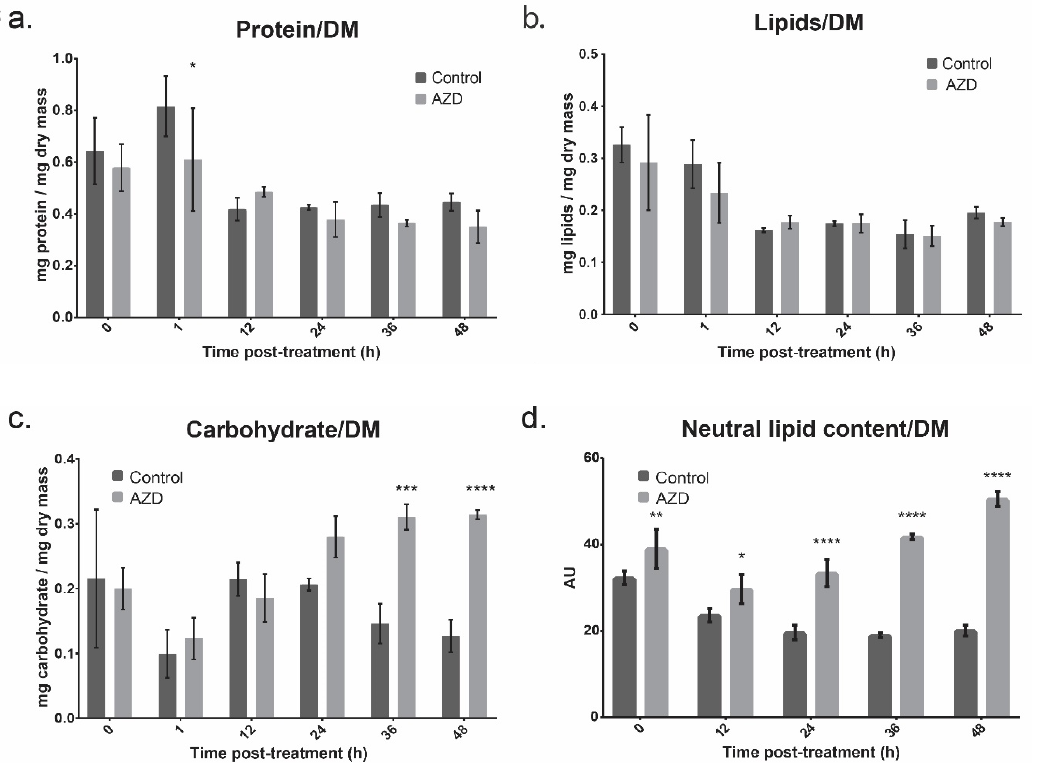
Figure 3. Compositional analysis of C. reinhardtii cultures with and without AZD8055 treatment, taken over time. The error bars represent standard deviation and statistical differences indicate a difference between the inhibited and non-inhibited cultures at one time point. Significance is denoted by asterisks, where * indicates p ≤ 0.05, ** indicates p ≤ 0.01, *** indicates p ≤ 0.001, and **** indicates p ≤ 0.0001. ( a ) The total protein content of the cultures, measured in mg/mg dry mass, with and without AZD8055 treatment. ( b ) The total lipid content of cultures, measured in mg/mg dry mass. ( c ) The total carbohydrate content of cultures, measured in mg/mg dry mass. ( d .) Neutral lipid content of the cultures with and without AZD8055 treatment measured using Nile Red staining.